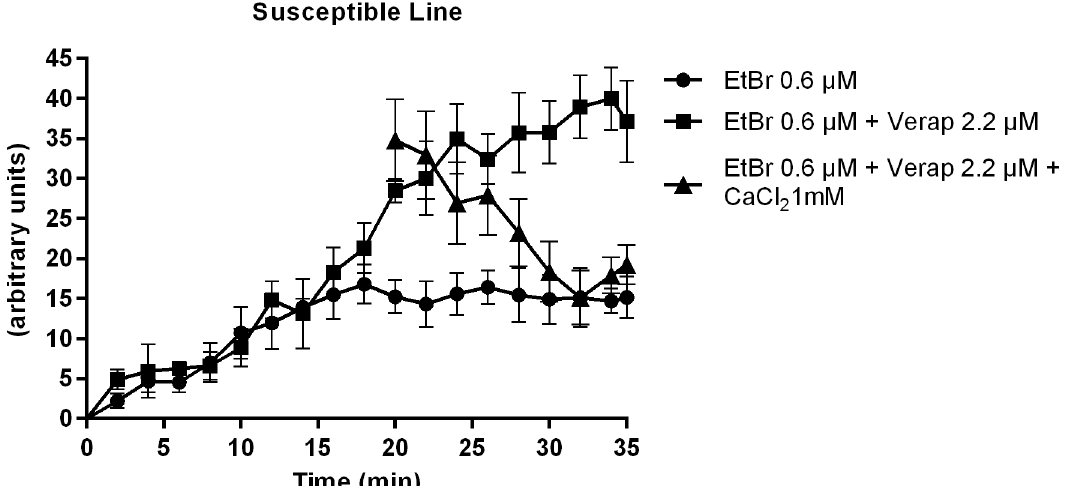
Fig 6. Variation in EtBr accumulation (Mean relative fluorescence). In the presence and absence of Verapamil and after the addition of CaCl 2 in S . mansoni PZQ-susceptible adult males. Three worms were used for each group and the experiment was performed three times. Quantification measurements were made in three areas of the worm central section (below the cecum ramification) and background fluorescence was subtracted for each parasite at each time-point. The average measurement was calculated for each time-point. Data are expressed as mean fluorescence of the EtBr accumulated intracellularly over time.